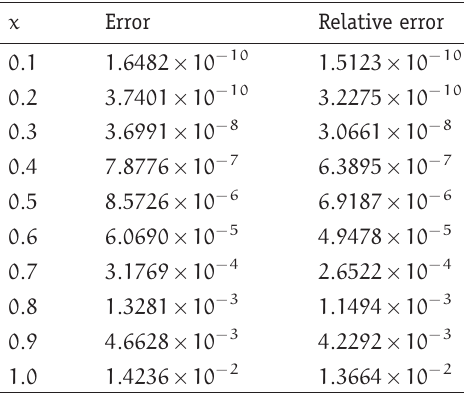
Table 3.5. Error that results from comparing the solution derived by the Laplace transform numerical algorithm with four iterations , and the numerical solution obtained using